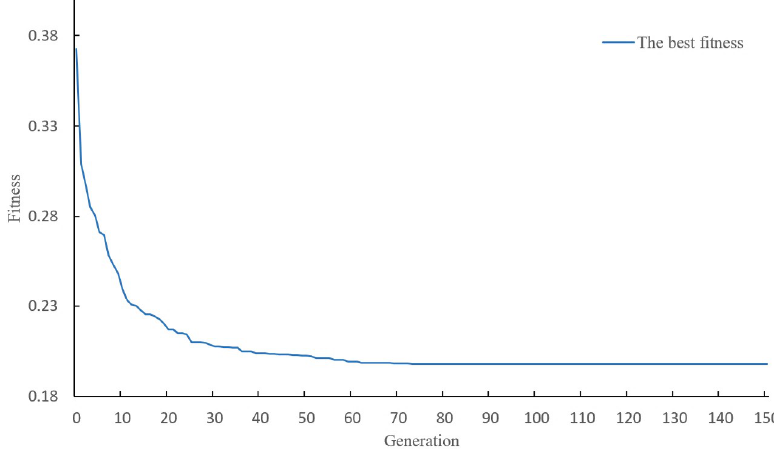
Figure 4. The best fitness of